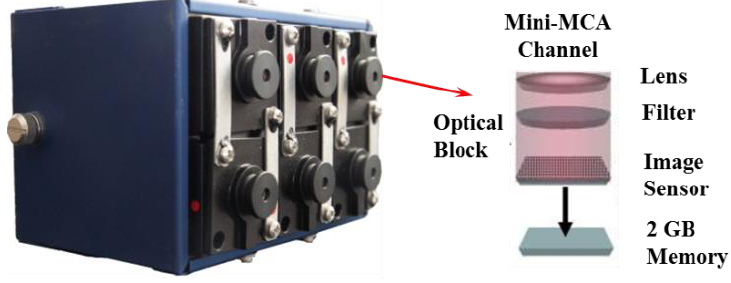
Figure 1. Mini-MCA multispectral camera.